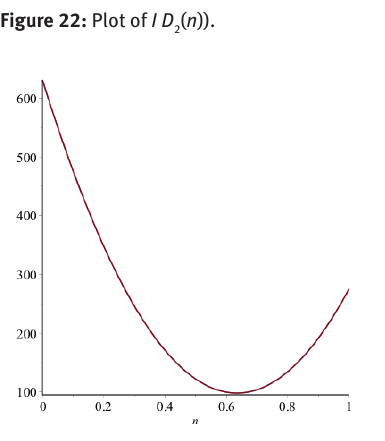
Figure 22: Plot of I D